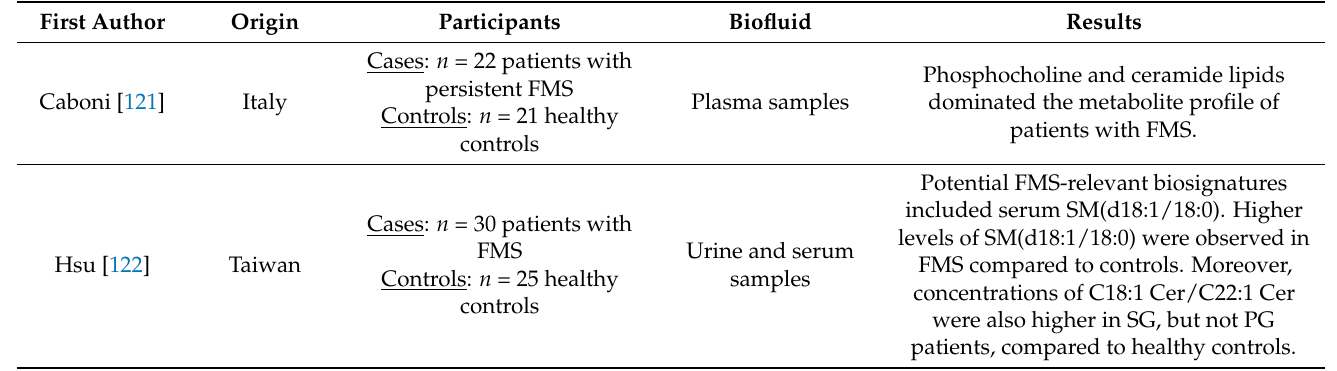
Table 3. Summary of studies assessing ceramide levels in patients with